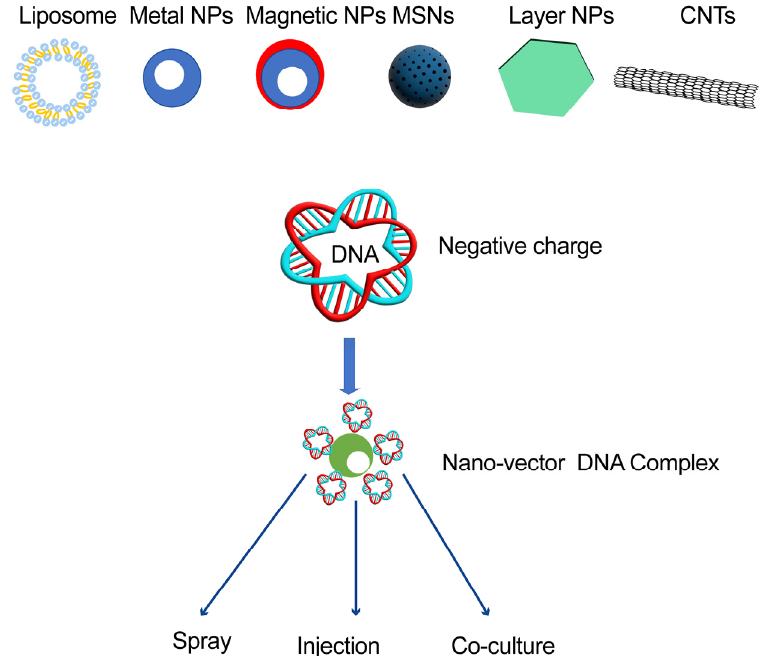
Figure 1. The gene nanovectors for future breeding works in different plants. Several types of nanomaterials, such as the liposome, modified metal nanoparticles (NPs), magnetic NPs, mesoporous silica nanoparticles (MSNs), layered double hydroxides (layer NPs), and carbon nanotubes (CNTs) have been used to deliver cargo genes into plants. Since the target nucleotide (DNA and RNA) are negatively charged, these nanovectors are positively charged. The nanomaterial–DNA complex could be delivered to plant cells by spraying, injection, or co-culturing, to improve the performance of the plants.